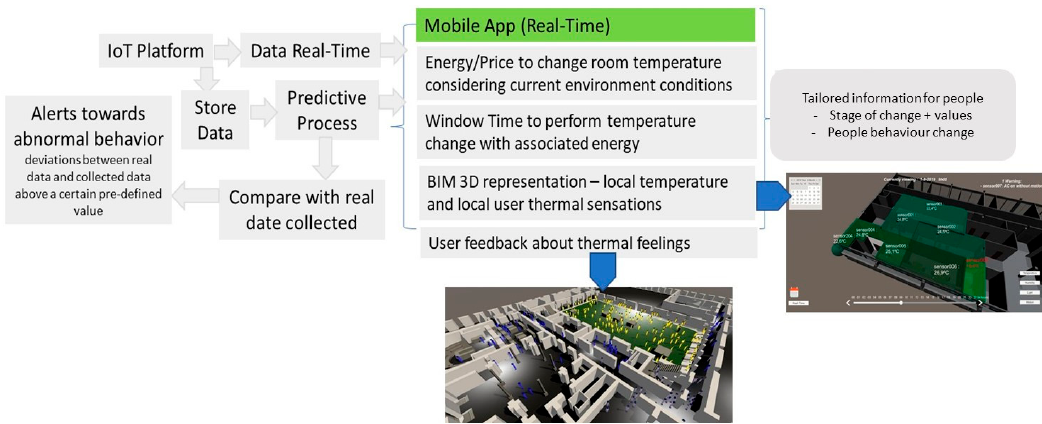
Figure 1. Proposed approach implemented to change people’s behaviour.